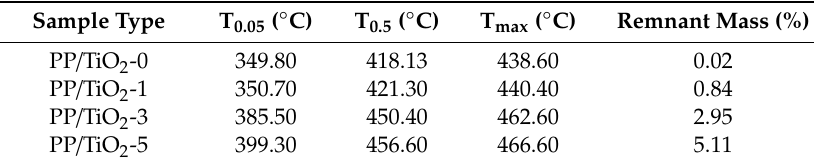
Table 3. TGA and DTG results of PP / TiO 2 melt-blown membranes.